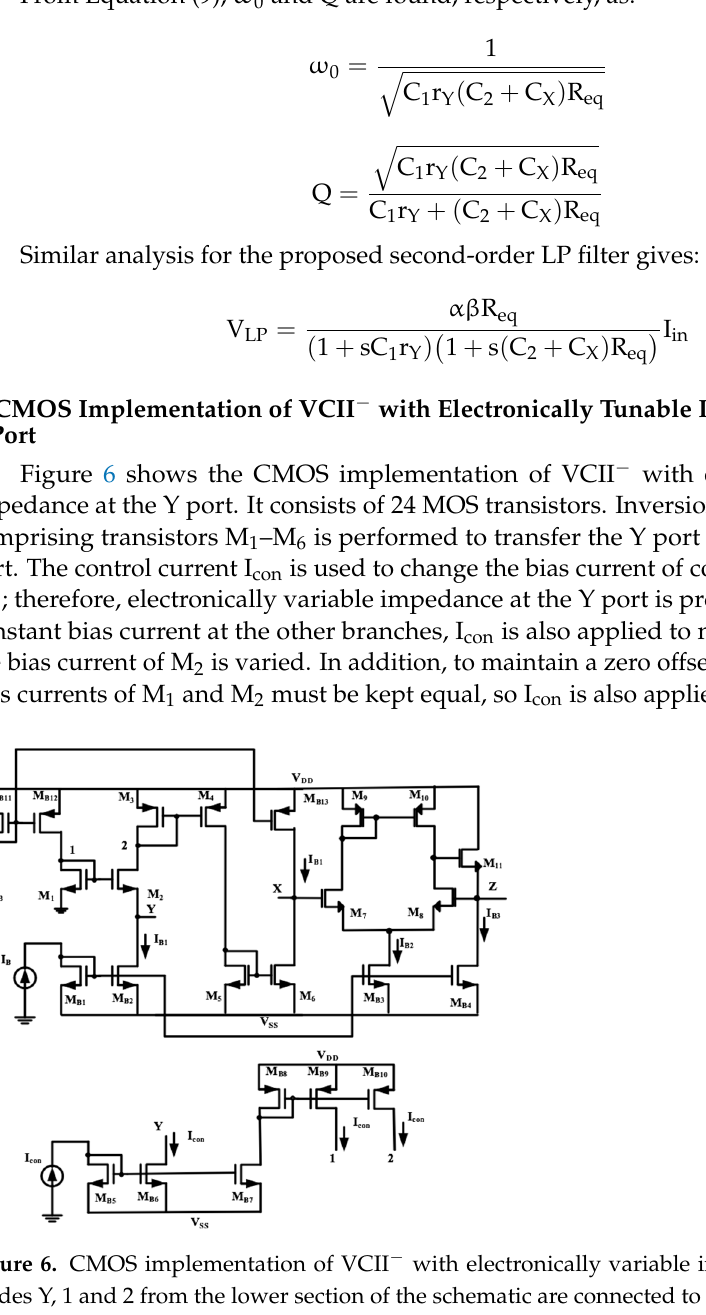
Figure 5. The proposed second-order BP filter with VCII - non-ideal components.